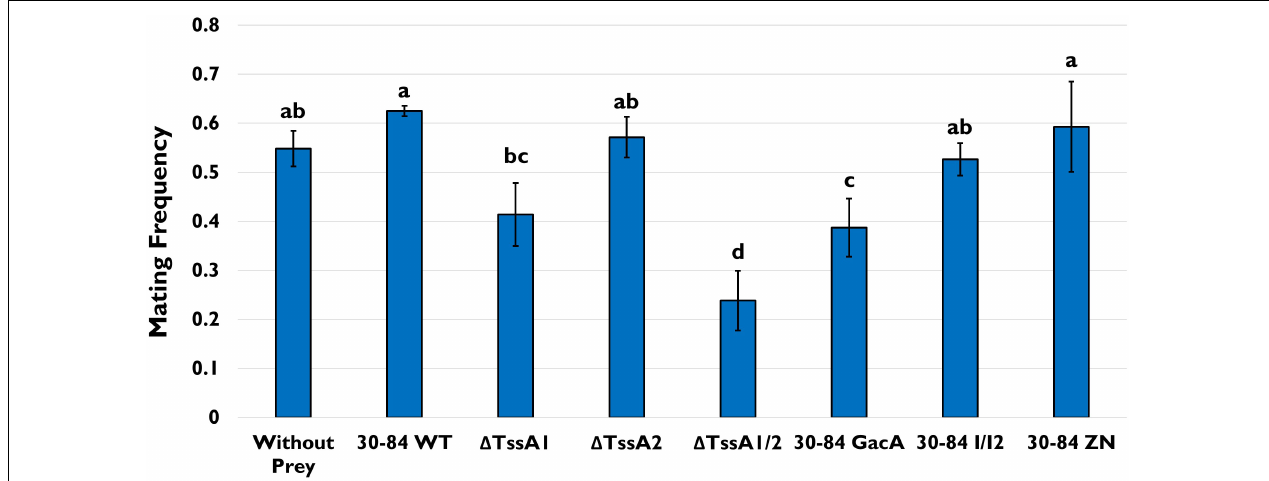
FIGURE 8 | Tetrahymena mating assay. T. thermophila CU427 and CU330 were grown separately overnight in Tris Buffer (pH = 7.4) to induce starvation. Populations were standardized to a cell density of 1.5 – 2 × 10 5 /10 mL (via direct counts) in fresh Tris Buffer and mixed together with only the bacterial strain as a food source. Bacteria used as prey included 30–84 WT, (cid:49) TssA1, (cid:49) TssA2, (cid:49) TssA1/2, 30–84 GacA, 30–84 I/I2, or 30–84 ZN, and the T. thermophila pairs without prey was used as a negative control. After 4 h, the treatments were viewed using a Leitz (Epivert) microscope (100X magnification), and the frequency of mated cell pairs (number of mated pairs/total number of observations) determined. Mean frequencies and standard errors are shown. This experiment was repeated three times ( n = 3). Letters denote significant differences. Data were analyzed using one-way ANOVA and Student t -tests, p < 0.05.